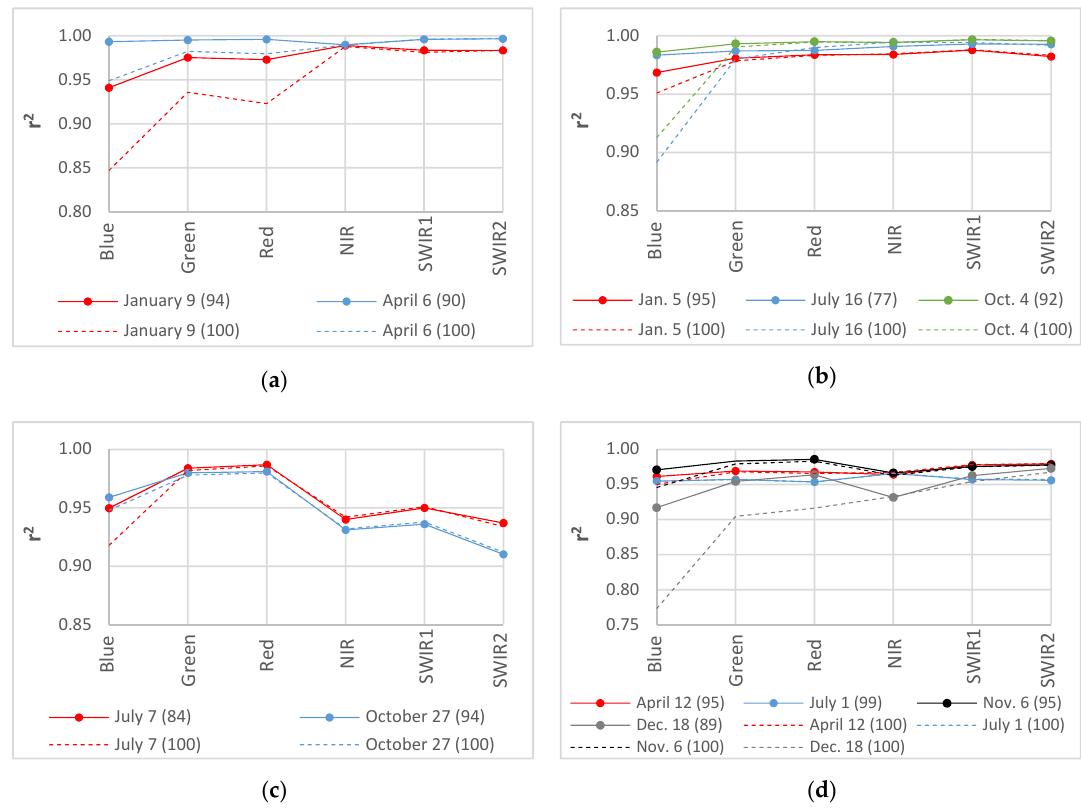
Figure 5. Coefficient of determination (r 2 ) between L8 PANSH and L8 L2 images in the six tested bands for each study site considering only the polygons without high aerosol level in each date (number of polygons free of aerosol in brackets): ( a ) SS1 (Almería); ( b ) SS2 (Agadir); ( c ) SS3 (Bari); ( d ) SS4 (Antalya). For comparison, the original r 2 values (100 polygons) are shown as dashed lines. The worse results in NIR, SWIR1 and SWIR2 bands in SS3 (Figure 5c) could be related to the high spectral homogeneity of the PCGs in an area dedicated to a vineyard monoculture where the reflectance values varied in a very short range. In fact, the best consistency statistics in terms of RMSE (0.860%) and r 2 (0.995) were achieved in SS3 when all the surface reflectance values (L8 PANSH vs. L8 L2) for the six common bands and the total dates per study site over the 100 polygons (i.e., 3600 data points in SS1, 1800 in SS2, 1200 in SS3 and 3000 in SS4) were used together. RMSE values of 1.635%, 1.348% and 1.277% and r 2 of 0.989, 0.989, 0.987 were attained for SS1, SS2 and SS4, respectively.